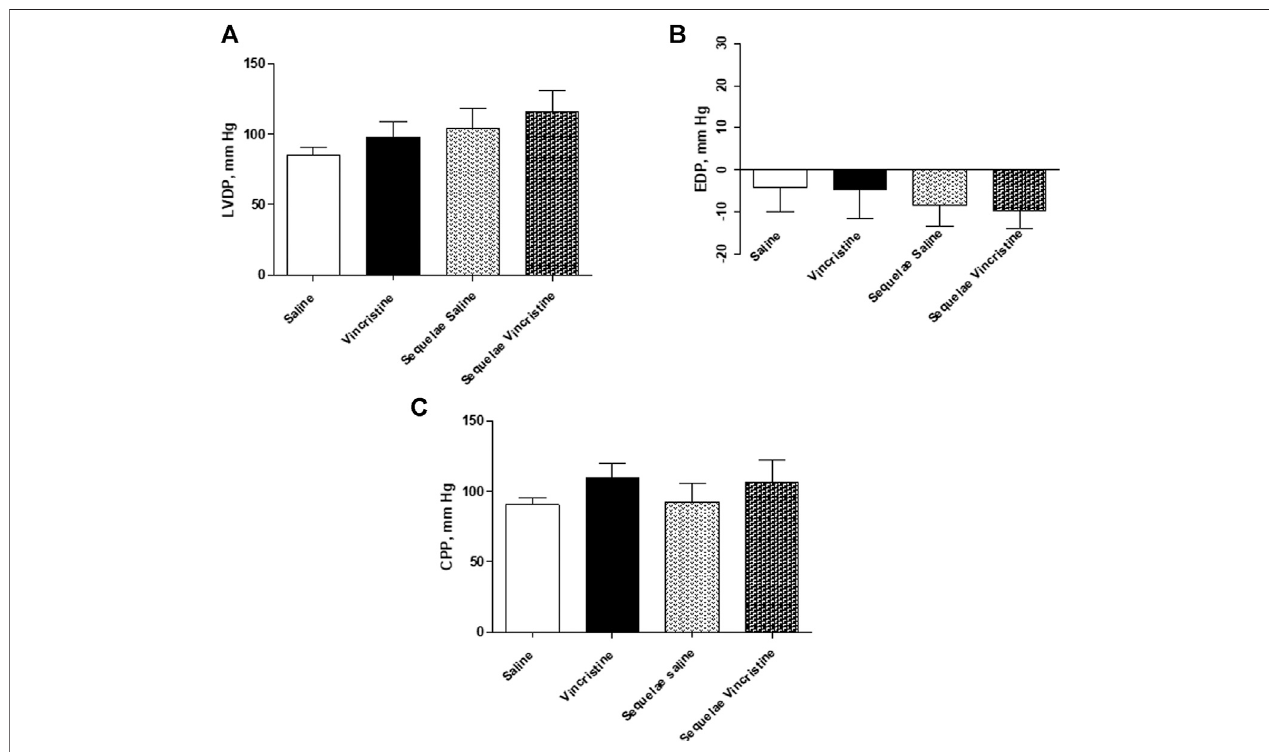
FIGURE 2 | Basal values of (A) left ventricular developed pressure (LVDP), (B) end-diastolic pressure (EDP), and (C) coronary perfusion pressure (CPP) of isolated hearts from animals chronically treated with saline (saline treatment) or vincristine (vincristine treatment) and two weeks post-treatment (sequelae saline and sequelae vincristine). Data represent the mean ± SEM, n (cid:2) 8 – 12 preparations per experimental group. A one-way ANOVA followed by Bonferroni ’ s multiple comparison test was used for statistical